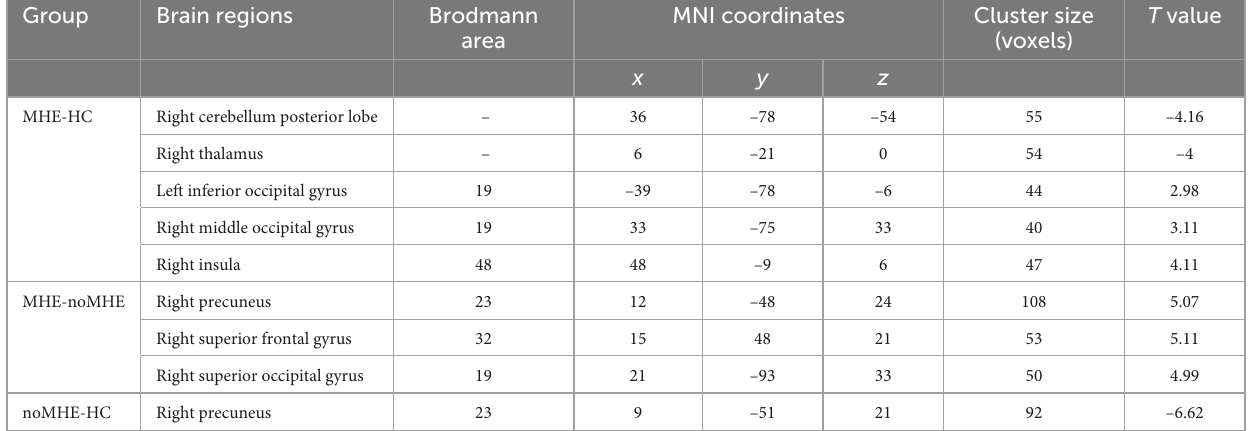
TABLE 2 Group differences in dynamic amplitude of low-frequency fluctuation (dALFF) between mild hepatic encephalopathy (MHE) patients, cirrhosis without MHE (noMHE) patients, and healthy controls (HCs). Group Brain